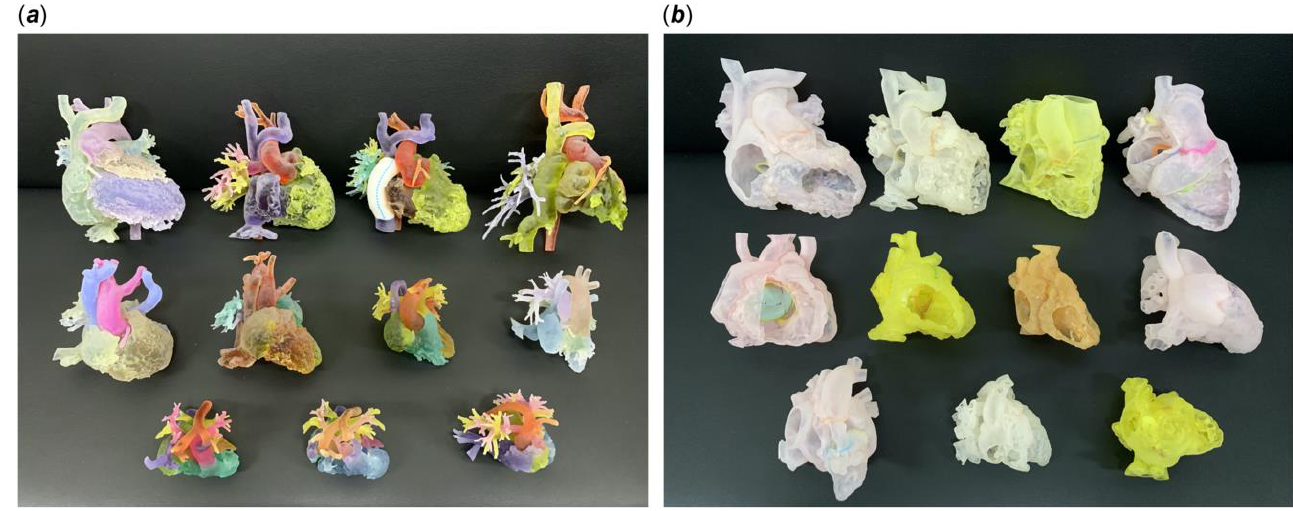
Figure 6. Three-dimensional-printed models of different kinds of complex CHD. ( a ) Blood pool models, ( b ) hollow models. Reprinted with permission from Lee C and Lee J [55].